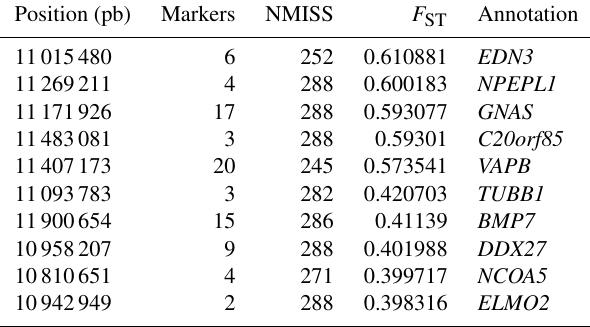
Table 2. Summary of the most interesting candidate genes within extreme signatures on chromosome 20.